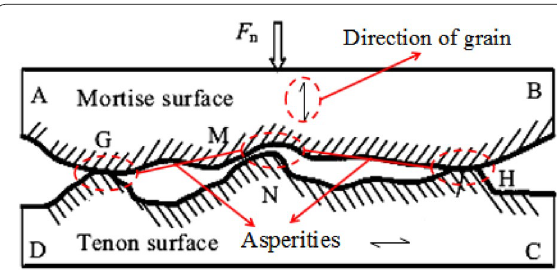
Fig. 4 The normal contact surfaces of M&T joint at the microscopic scale